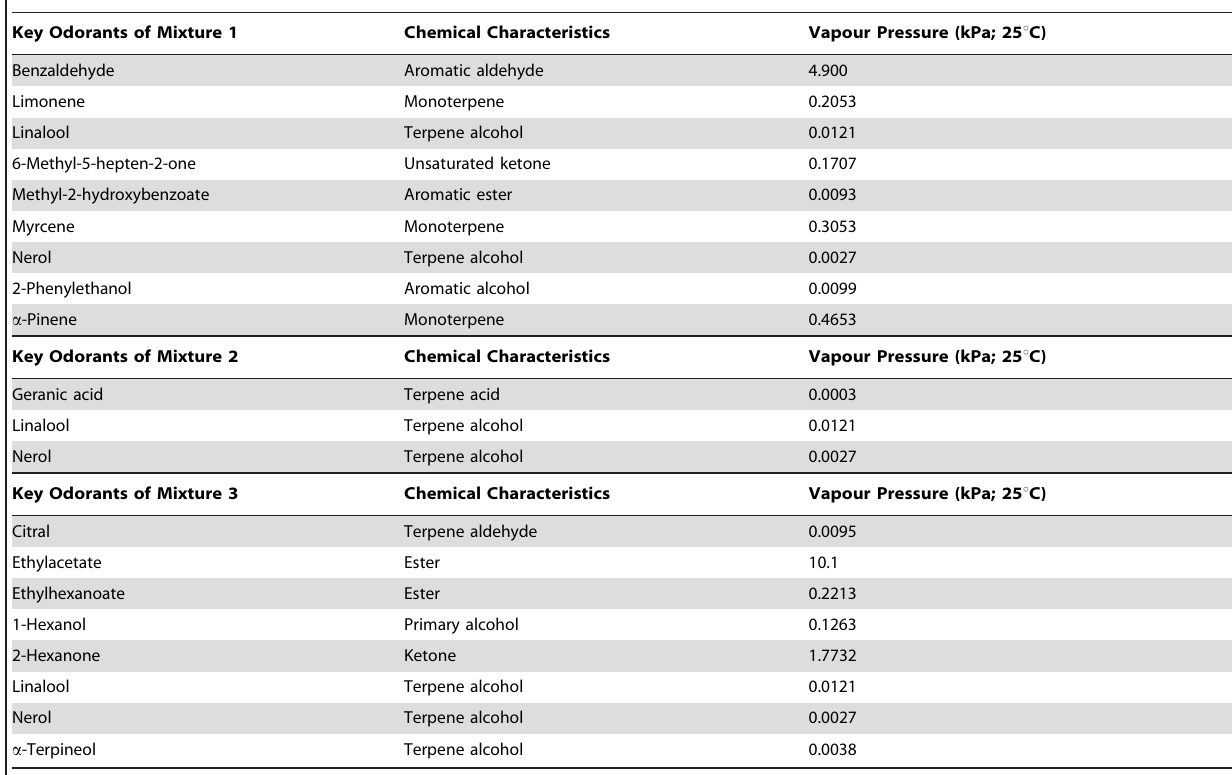
Table 3. Physico-chemical Characteristics of Key Odorants.